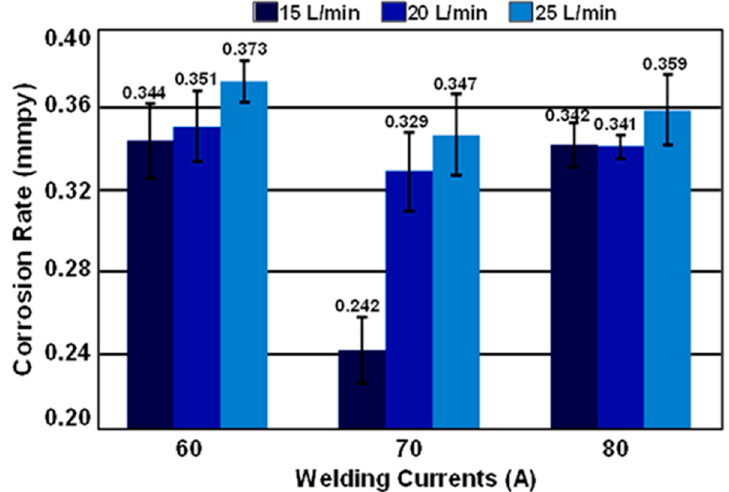
Figure 9. Corrosion rate of the pieces that connect with the heat input of welding at 0.91, 0.95, and 1.04 kJ/mm, at test flow rates of 15, 20 and 25 L/min.